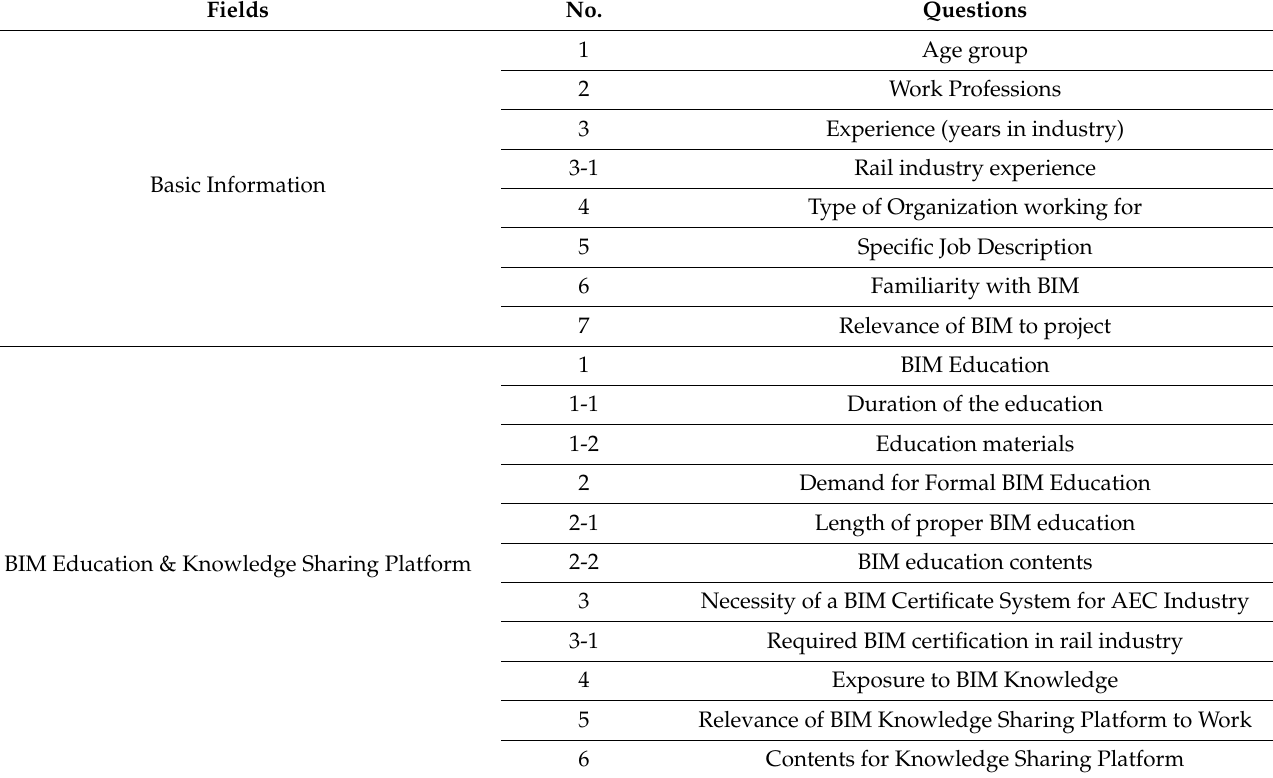
Table 1. Survey Design and Delivered